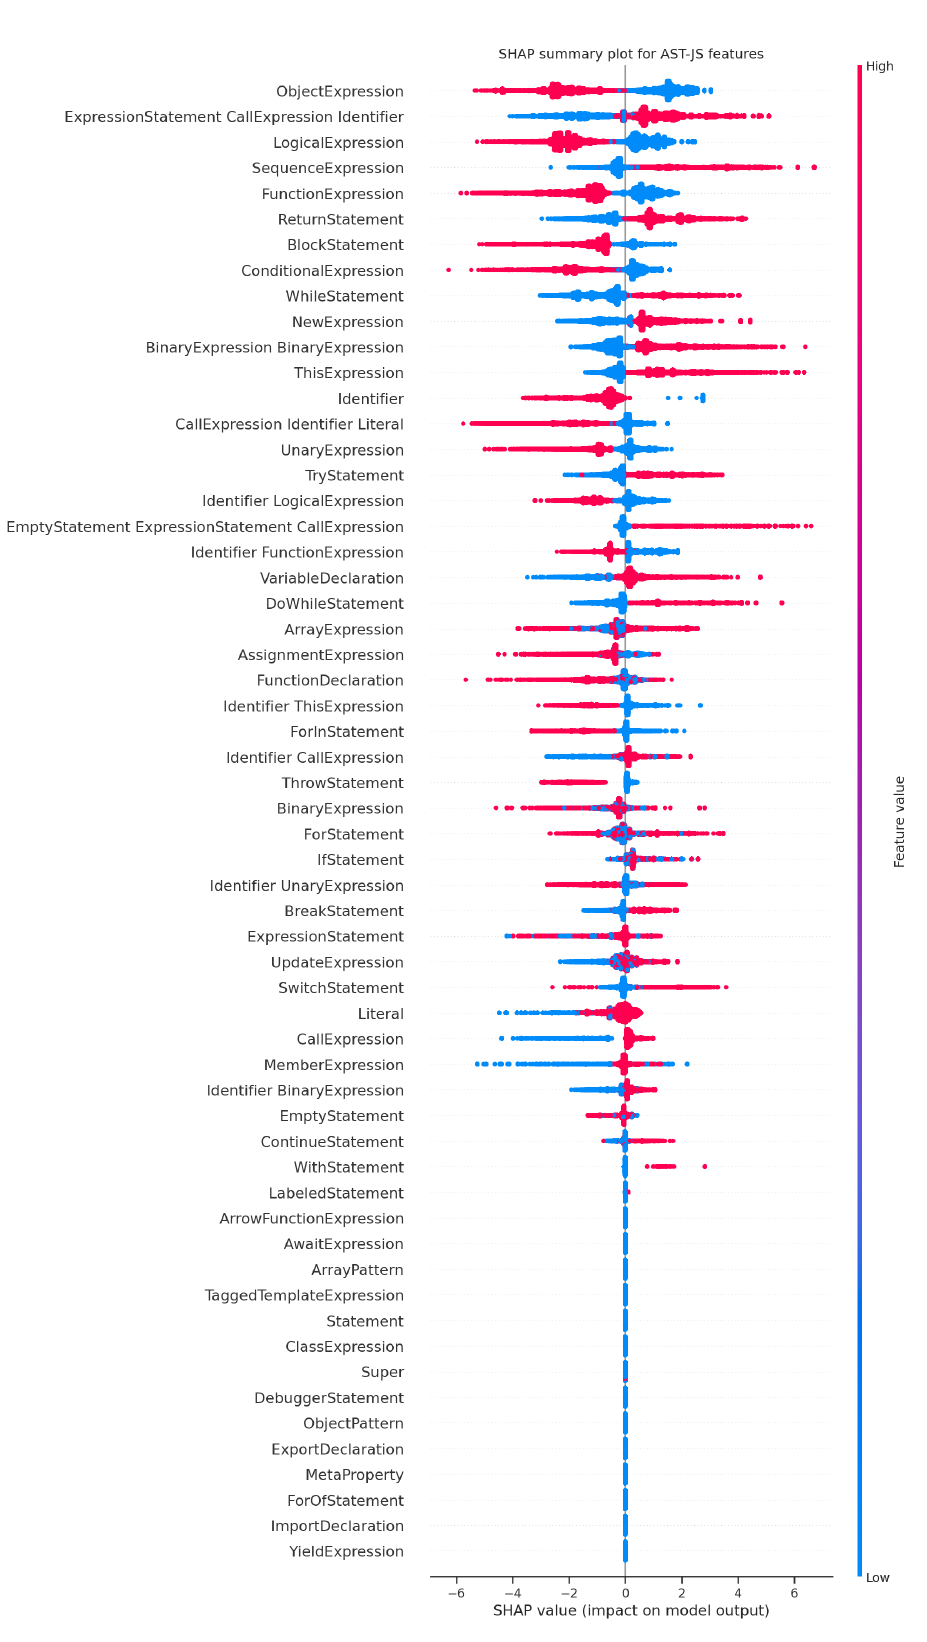
Figure 2. SHAP summary plot for AST-JS